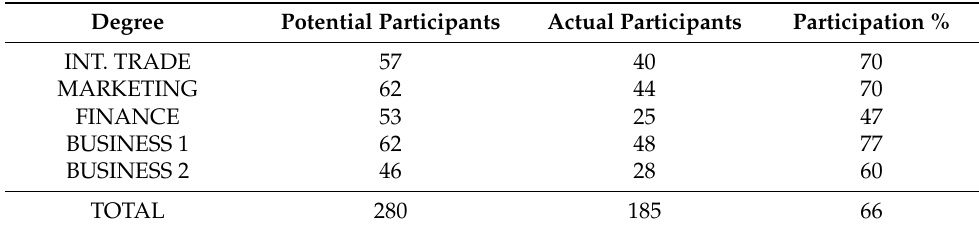
Table 1. Students and participants in the survey by